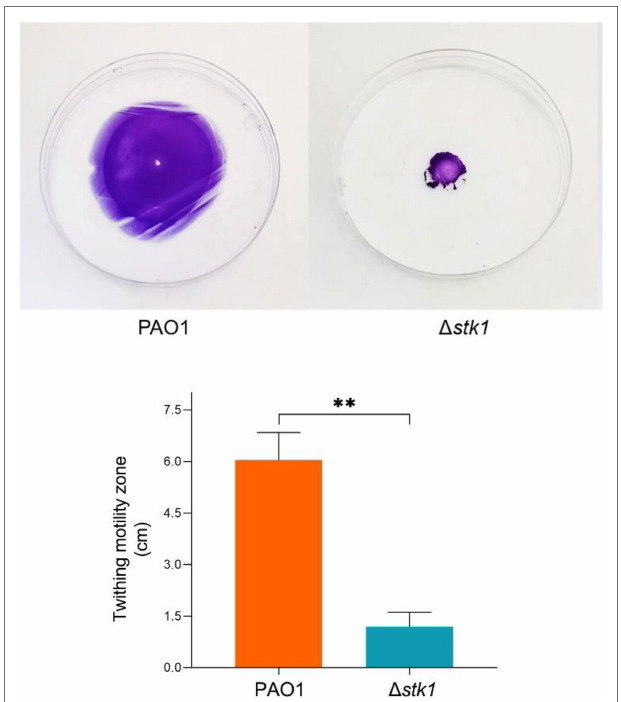
FIGURE 9 | The stk1 deletion attenuates the function of the type IV pilus. Detecting the effect of twitching motility can reflect whether the function of type IV fimbriae functions normally. The PAO1 and Δ stk1 strains were both cultured overnight and then added dropwise to the middle of the medium. They were incubated at 37 ° C for 24 h and then stained with 1% crystal violet solution for 15 min. Twitching motility diameters were measured. The data represent the average values as the means (SD) from three independent experiments ( ** p < 0.01).